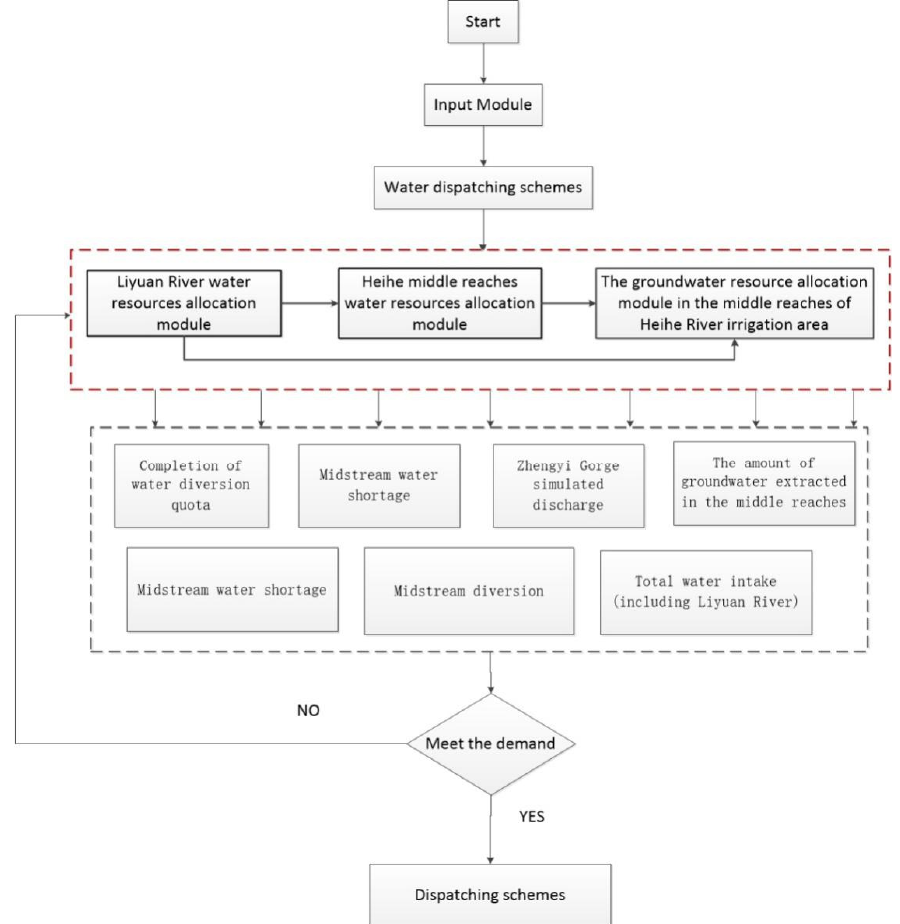
Figure 5. Framework of the water resource allocation model.